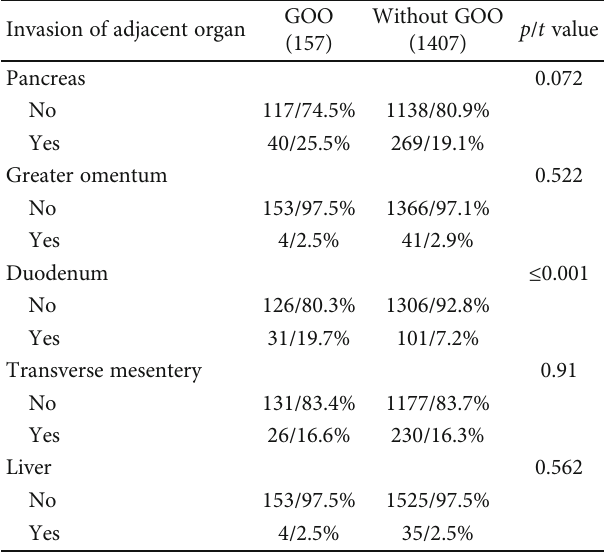
Table 2: The invasion of adjacent organs in patients with and without GOO.